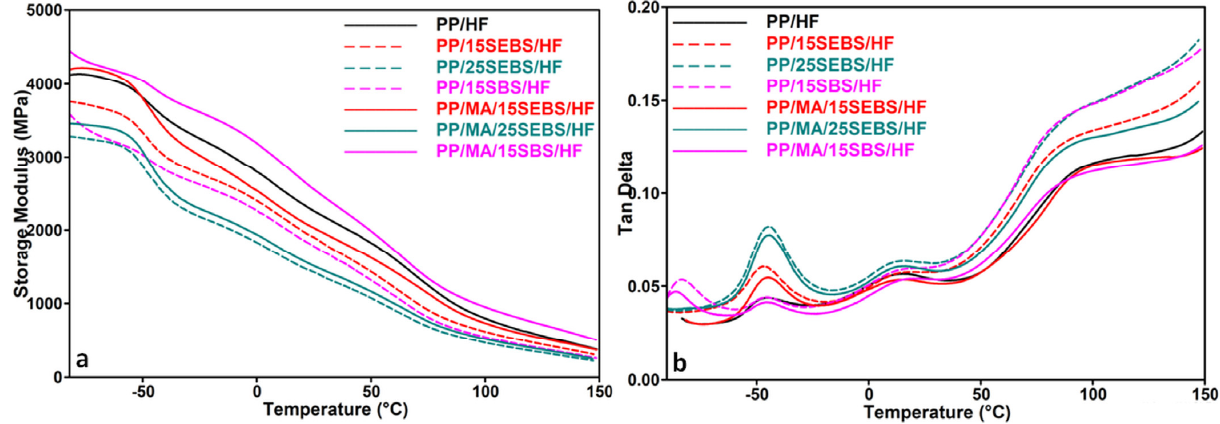
Figure 4. Storage modulus and tan δ vs. temperature profiles for PP/HF composites. Table 2. Storage modulus ( E ′ ) at selected temperatures; glass transitions of SEBS ( T gSEBS ), SBS ( T gSEBS ), PP ( T gPP ), and of the elastomeric segments in the PP copolymer ( T ′ g ); T α PP is characteristic to crystalline PP.